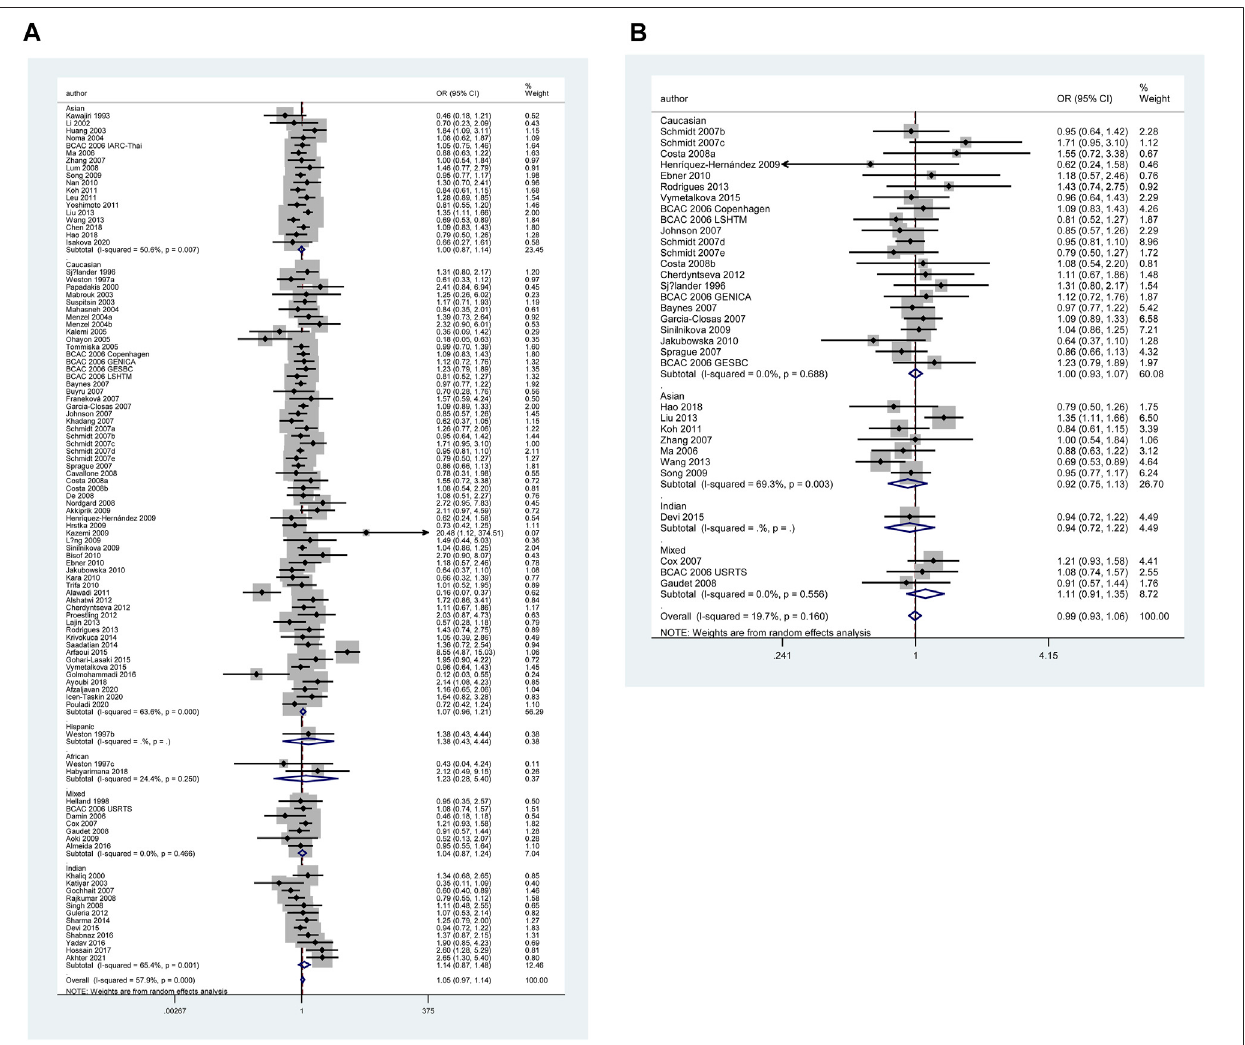
FIGURE2| Forestplotoftheassociationbetween TP53 codon72polymorphismandBCriskinethnicitysubgroupanalysis(GGvs.CC+CG)[ (A) :Overallanalysis; (B) : Sensitivity analysis].